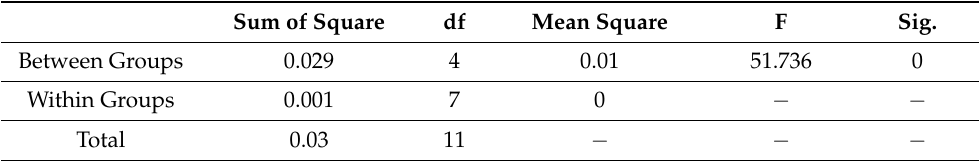
Table 3. % elongation for all samples using ANOVA method.